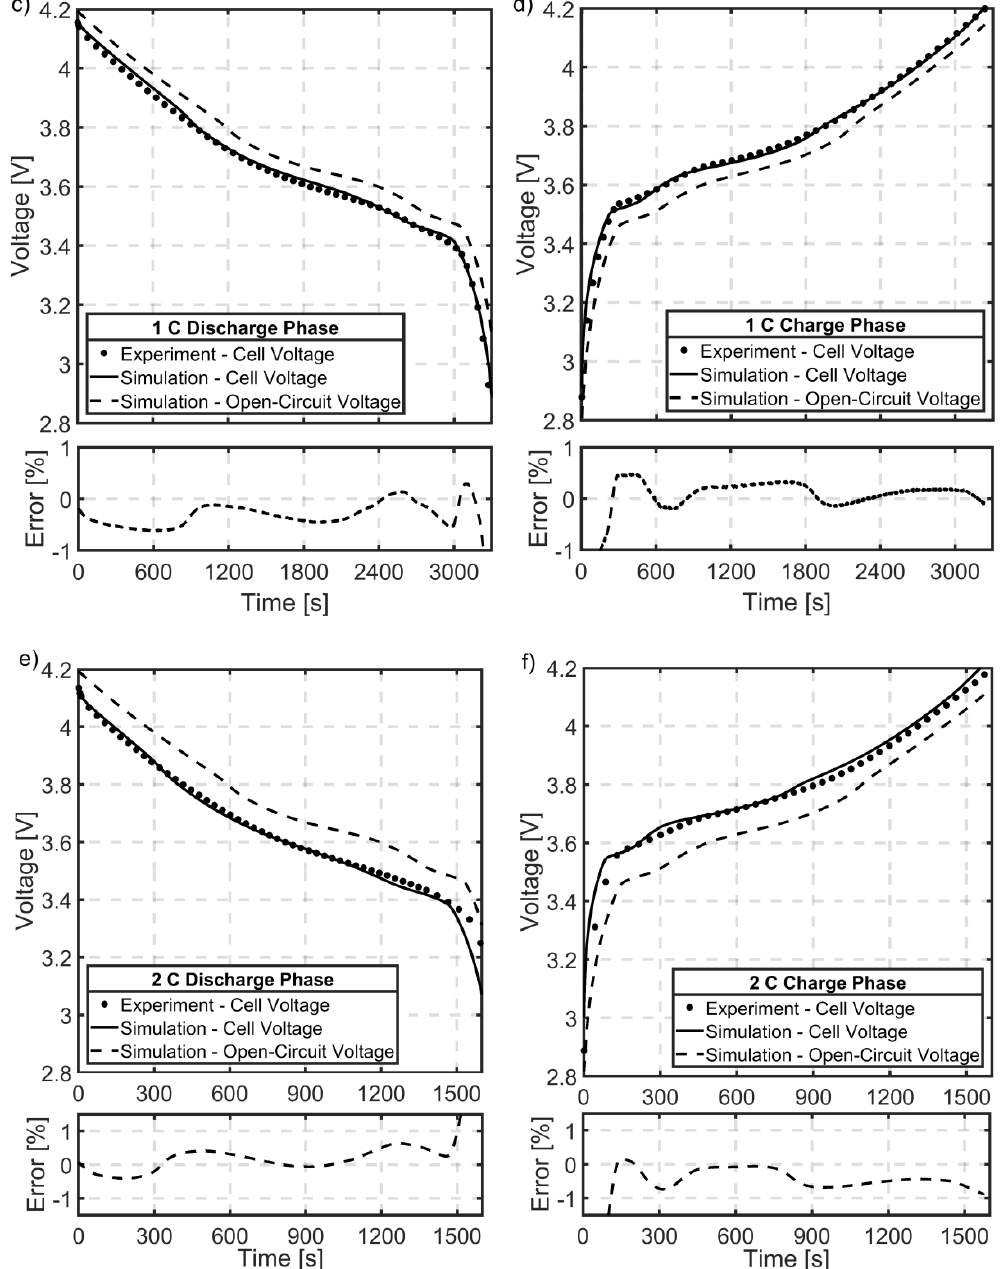
Figure 6. Experimental and simulated cell voltage profile (V) of the cell as a function of time (s) during a discharge and charge phase at: ( a , b ) 0.5 C, ( c , d ) 1 C, and ( e , f ) 2 C current rates. The cells were initially kept at a constant temperature of 25 °C for multiple hours in a fully charged/fully discharged state.